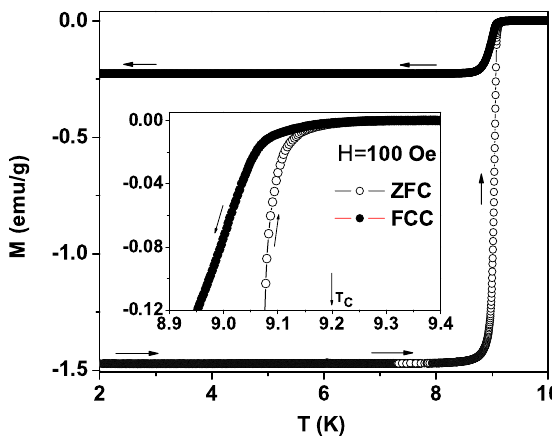
FIG. 8. Isothermal M versus H plots of (a) electron beam welded and electropolished niobium step joint (top), (b) electron beam welded and electropolished niobium butt joint (middle), and (c) electropolished as-received niobium (bottom), starting from the zero field cooled state at 4 K.